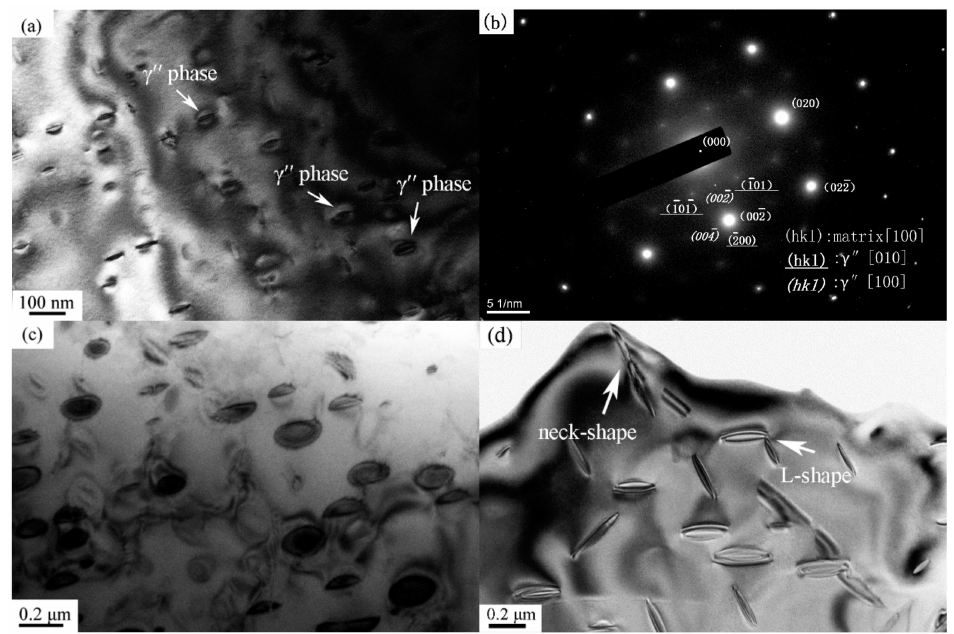
Figure 4. TEM images of ( a ) lip-shaped γ ” phase after isothermal aging at 900 ◦ C for 2 h; ( b ) selected area di ff raction pattern of γ ” phase; ( c ) disc-shaped γ ” phase after isothermal aging at 900 ◦ C for 5 h; ( d ) "neck" and L-shaped structures of γ ” phase after isothermal aging at 900 ◦ C for 5 h.